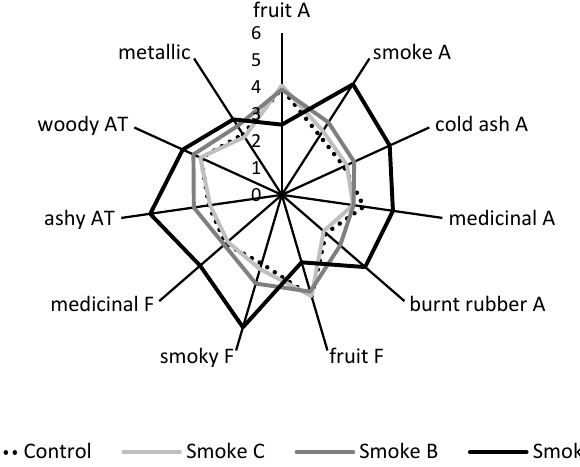
Figure 3. Sensory profiles of control and smoke-affected Shiraz wines; A = aroma, F = flavor, and AT = aftertaste. Data are the mean intensity ratings for one blended wine per treatment, presented to 62 panelists; ratings for all attributes were statistically significant ( p ≤ 0.05, two-way